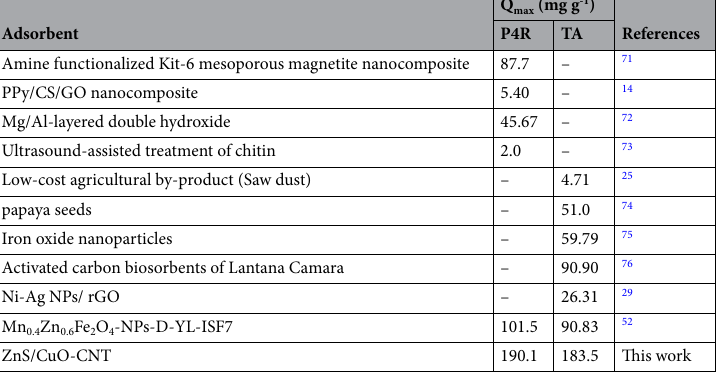
Table 7. Comparison of maximum adsorption capacity (Q max ) of some various adsorbent for P4R and TA food dyes.